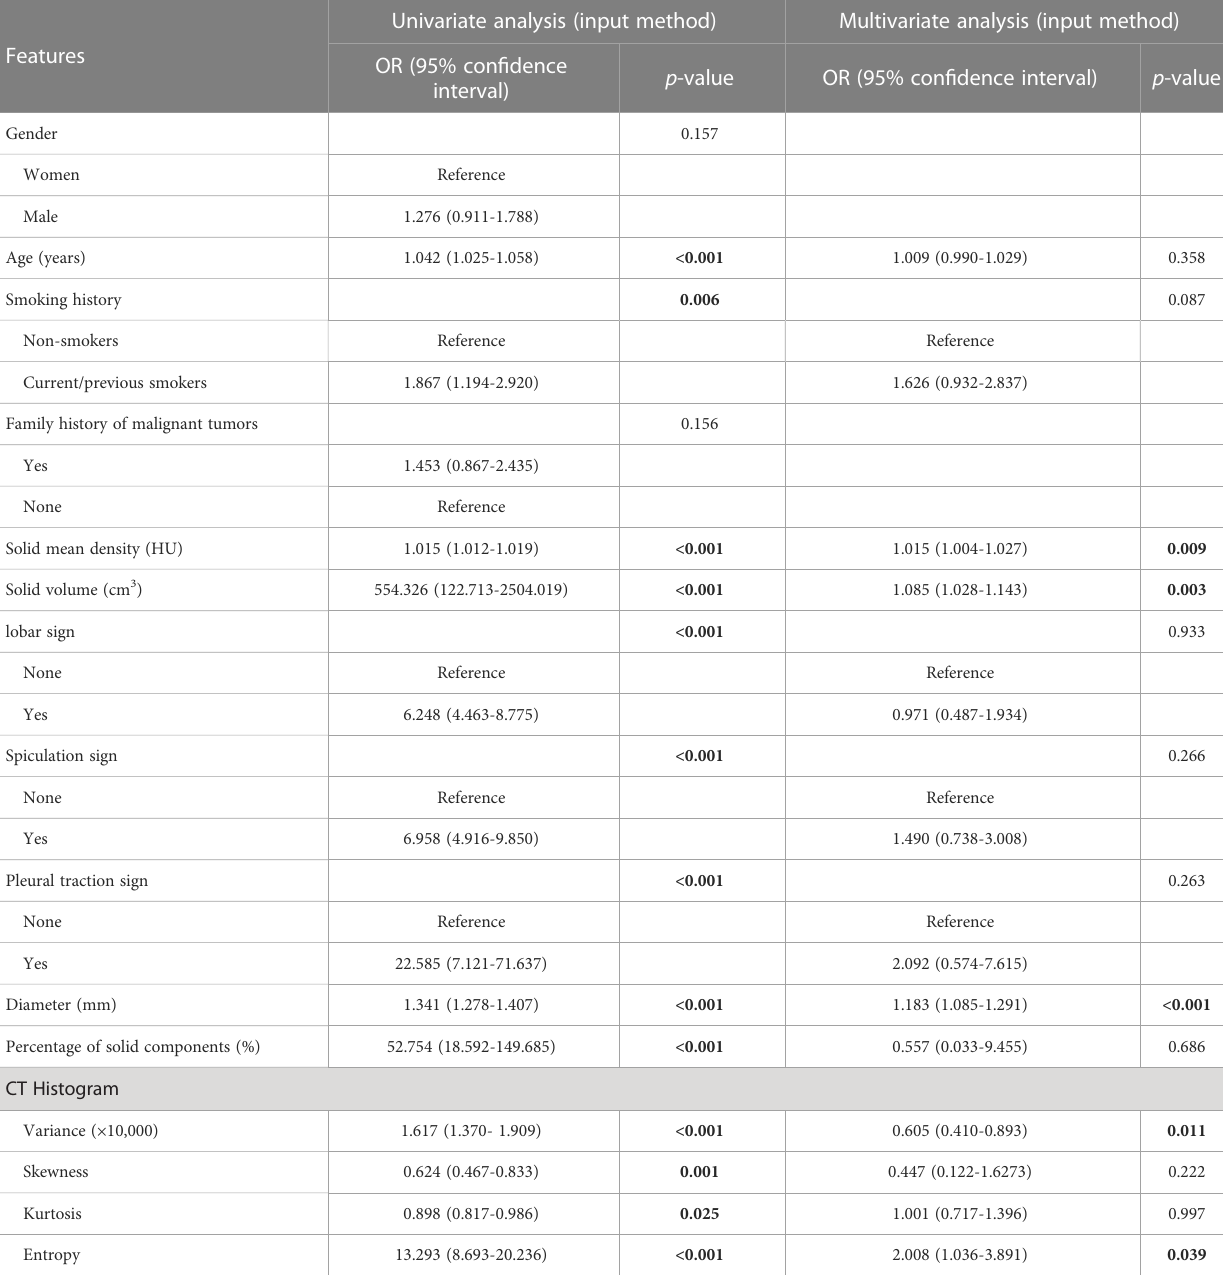
TABLE 3 Univariate and multivariate analyses of the ability of each factor in predicting invasive adenocarcinoma in the training cohort.